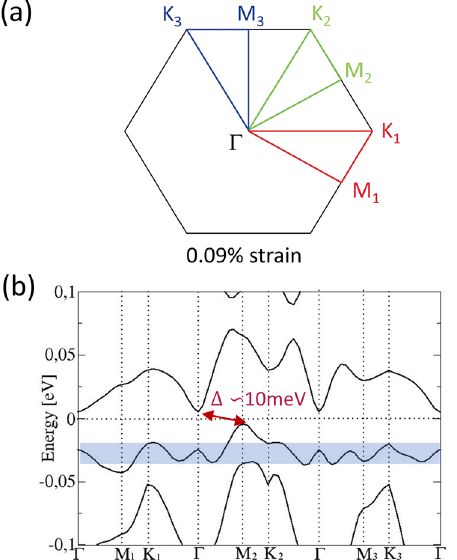
Fig. 9 Brillouin zone and band structure of the 2.2° twisted bilayer. a The hexagonal BZ for the 2.2° twisted GeSn bilayer; the points K 1 , K 2 , K 3 and points M 1 , M 2 and M 3 correspond to the unit cell consisting of 182 atoms. Without lattice distortions all K and M points have degenerate bandgaps. The degeneracy is broken when lattice distortions break lattice symmetry to minimize the total energy. b Electronic band structure of the 2.2° twisted GeSn bilayer, where the centre of inversion is absent, demonstrating fl at bands and an indirect bandgap of 10